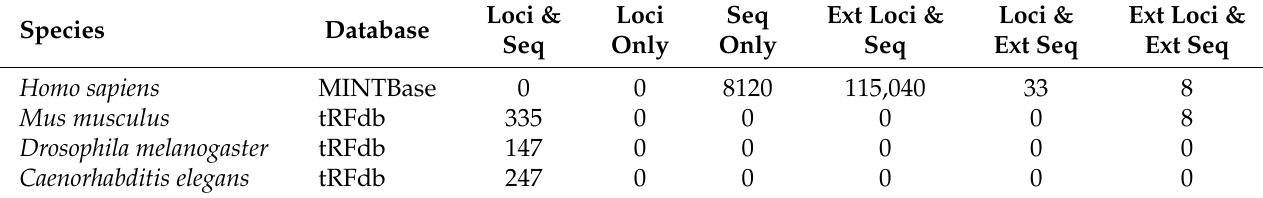
Table 3. Statistics on correction events in tsRNA entries for various species: cases when both locus and sequence were present ( Loci & Seq , no correction), only locus or only sequence ( Loci only , Seq only ), and cases that required extending entry’s locus, sequence or both ( Ext Loci & Seq , Loci & Ext Seq , Ext Loci & Ext Seq ).